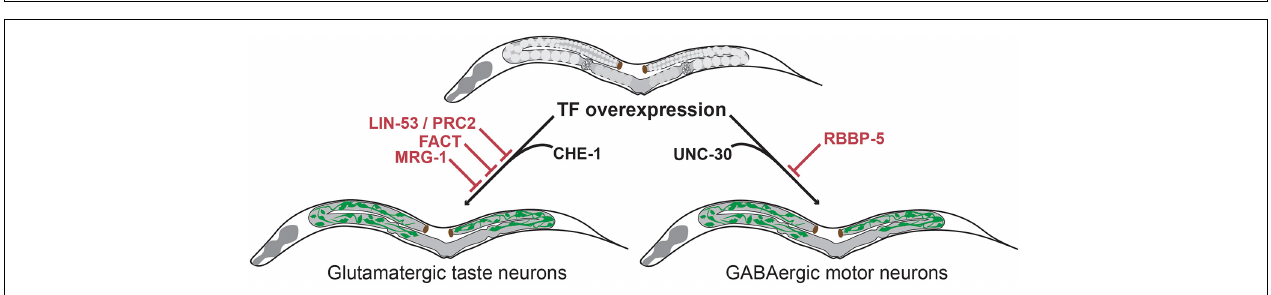
FIGURE 2 | Molecular mechanisms that maintain germline totipotency and prevent unsolicited induction of somatic fates. Upon loss of the translational regulators GLD-1 and MEX-3 germ cells spontaneously differentiate to somatic cells thereby forming germline teratomas that contain multiple cell types at once including neurons (Ciosk et al., 2006). Loss of the chromatin regulators SPR-5/LET-418 (Käser-Pébernard et al., 2014) and SET-2/WDR-5.1 (Robert et al., 2014) also result in germline teratomas. Loss of germline P-granules leads to differentiation of germ cells to neuron-like cells, which do no acquire characteristics of terminally differentiated neurons (Updike et al., 2014). Green cells indicate neuron-like cells, red cells indicate muscle-like cells.